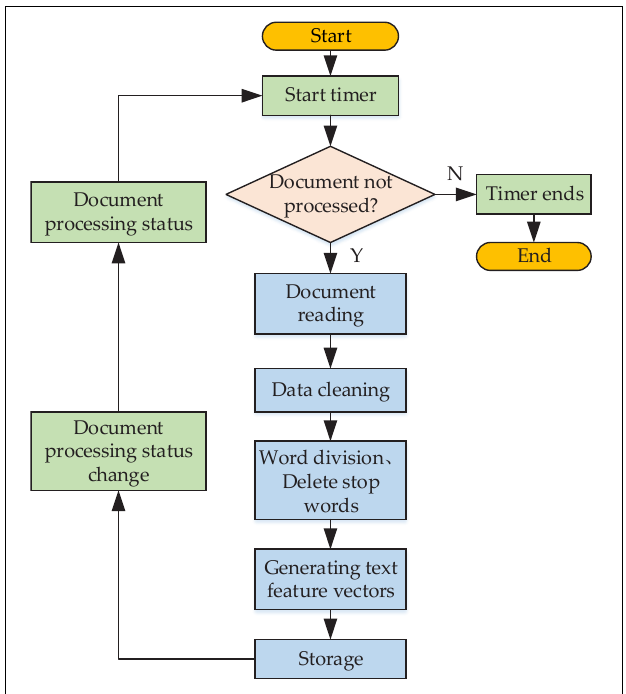
FIGURE 5 | The flowchart of the text representation module.